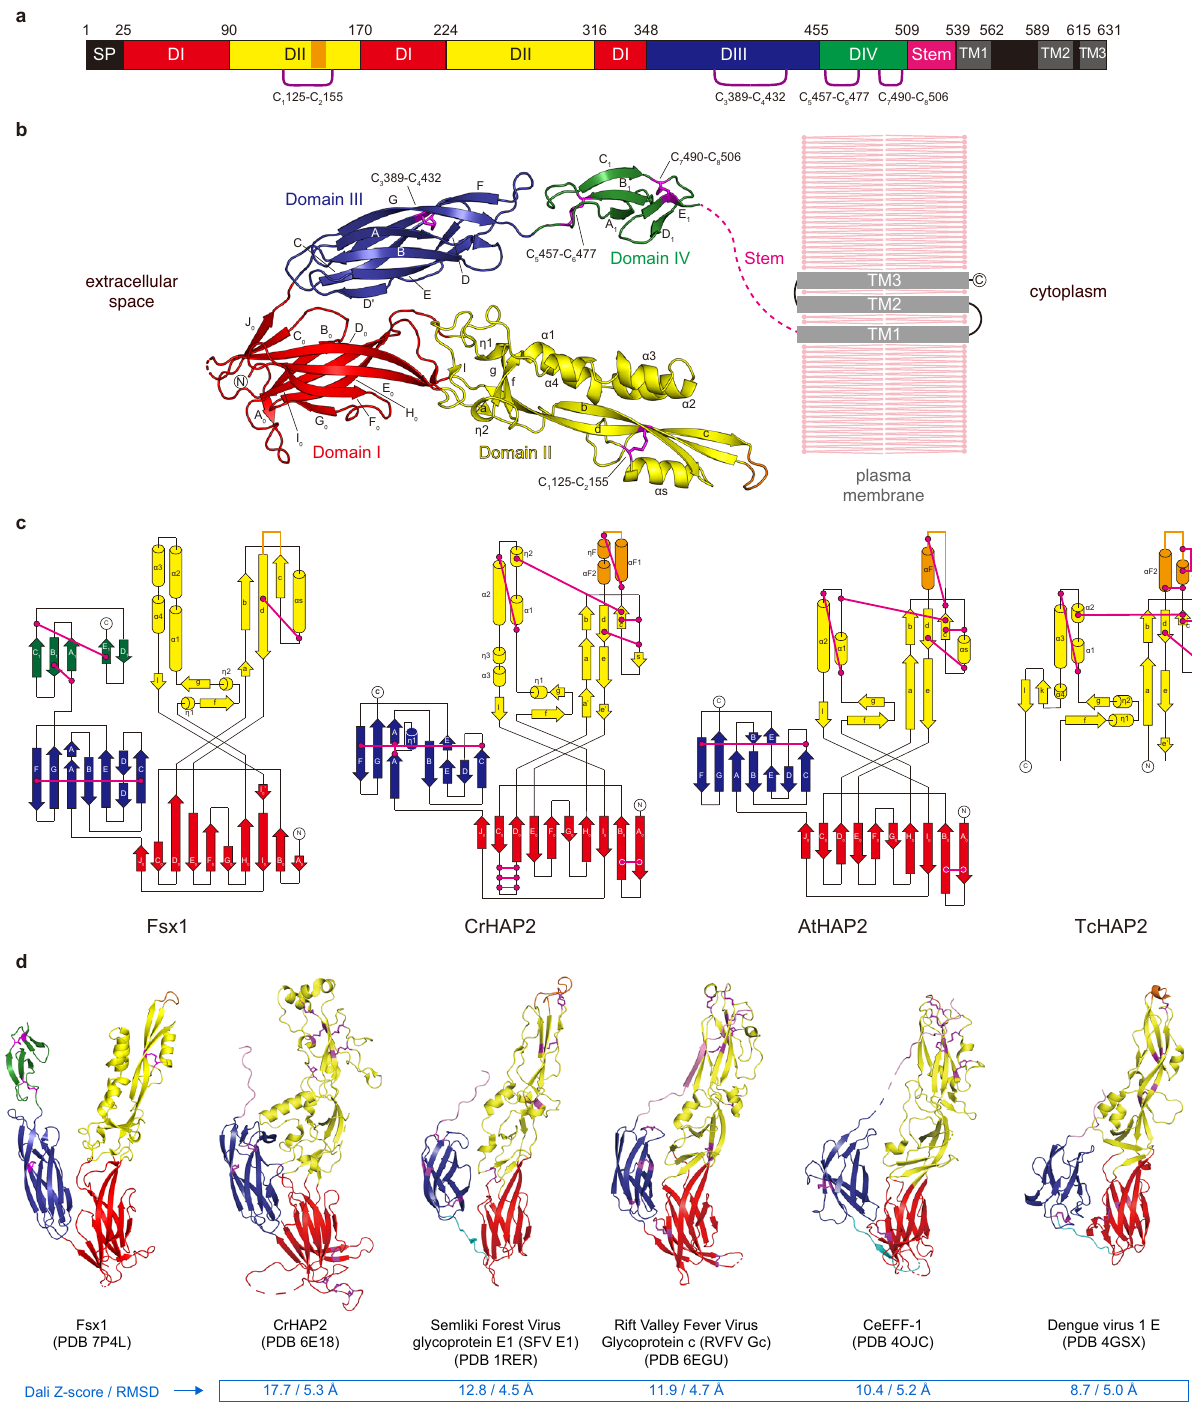
Fig. 2 Domain architecture of Fsx1 and topological comparison with HAP2. a Schematic diagram of the domains of Fsx1. SP, signal peptide; TM, predicted transmembrane helices. Note that Fsx1 is predicted to contain three C-terminal TMs, with a cytoplasmic loop between TM1 and TM2 that lacks Cys residues; on the other hand, HAP2 homologs are characterized by having a single TM, followed by a cytoplasmic tail that often contains Cys implicated in fusion 64 . b Crystal structure of the ectodomain of Fsx1 and predicted topology of the full-length protein relative to the plasma membrane. Domains I – IV are shown in red, yellow, blue, and green, respectively; disul fi de bonds are indicated and colored magenta. c Topology diagrams of the ectodomains of Fsx1, C. reinhardtii HAP2 (PDB 6E18 [https://www.rcsb.org/structure/6E18]) 65 , A. thaliana HAP2 (PDB 5OW3 [https://www.rcsb.org/structure/5OW3]) 25 , and T. cruzi HAP2 (PDB 5OW4 [https://www.rcsb.org/structure/5OW4]) 25 . Domains and disul fi de bonds are colored as in panel b . Note how, although domain II of Fsx1 has the same topology as the corresponding domain of HAP2, it contains only one of its conserved disul fi de bonds (C 1 125 – C 2 155, corresponding to C147-C210/disul fi de bond 3 of CrHAP2 23 ). d Side-by-side comparison of Fsx1 E and known class II fusogens. Elements are colored as in panel b ; the stem region and the linker between domains I and III are shown in pink and cyan,